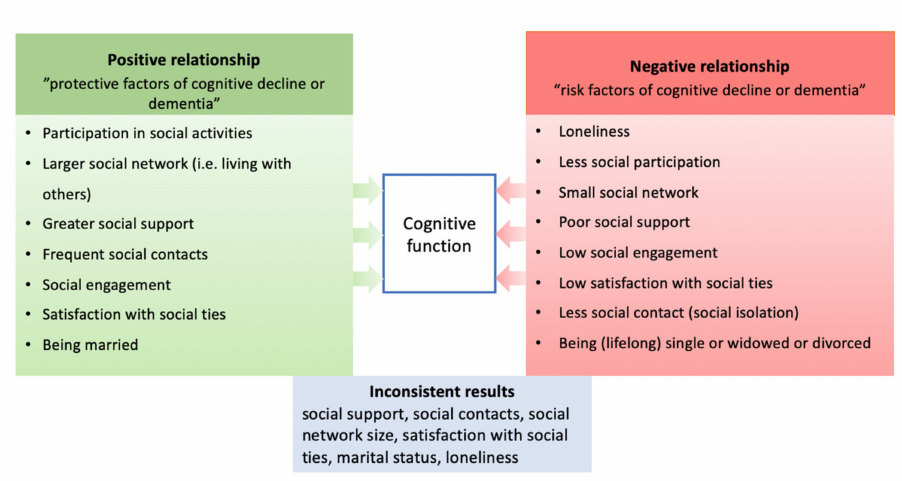
Figure 8. Social factors and their relationships with cognitive